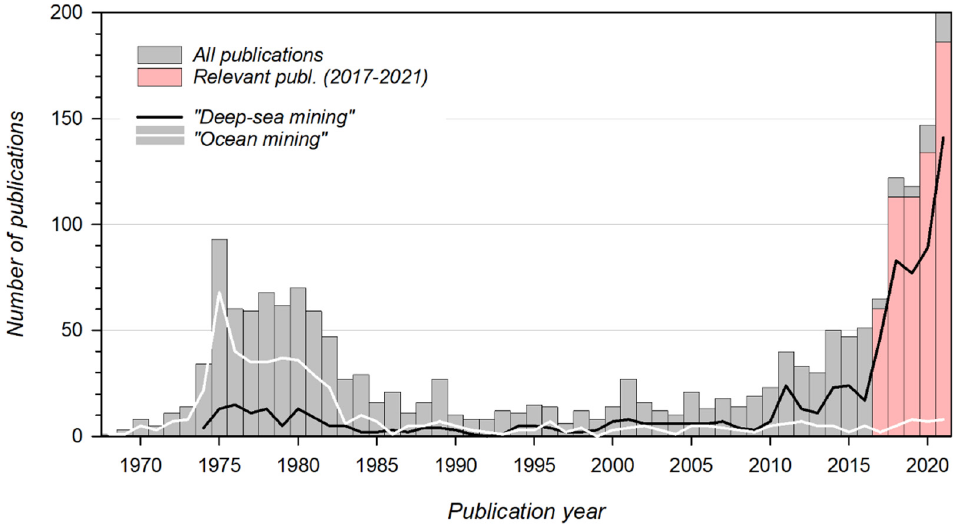
Figure 1. Scientific output (i.e., annual number of publications) from 1968 to 2021. The number of hits returned by the top two search terms are also shown.